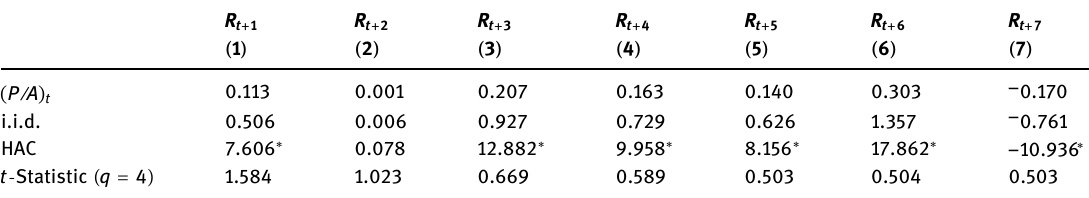
Table 5: Price - to - acceptance ratio of Bitcoin R t 1 + R t 2 + R t 3 +